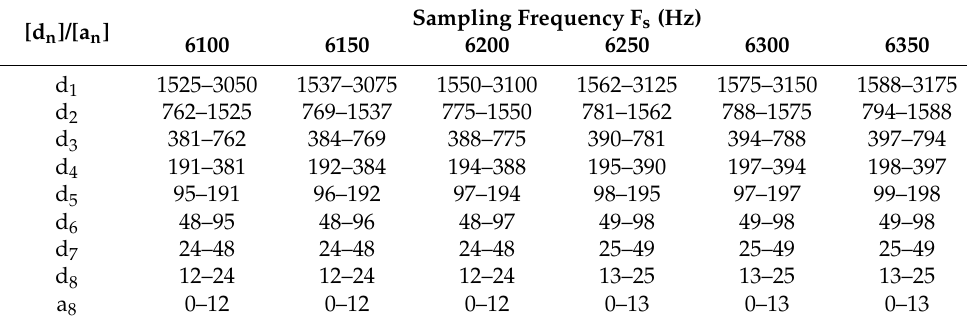
Table 1. Frequency bands of [d n ]/[a n ] for various sampling frequencies